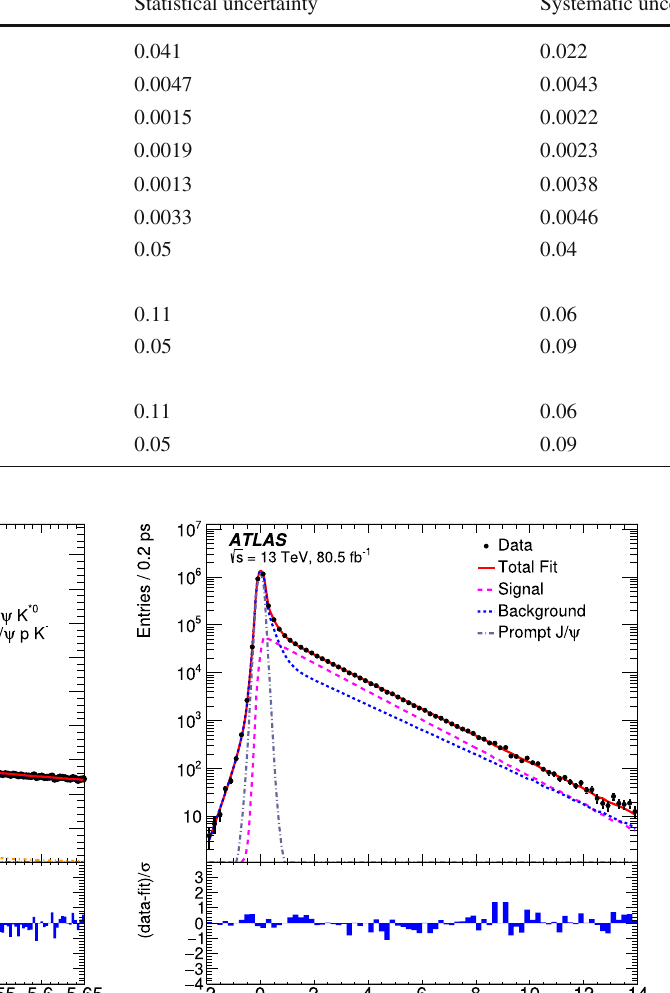
Table 6 Fitted values for the physical parameters of interest with their statistical and systematic uncertainties. For variables δ ⊥ and δ (cid:10) the values are given for the two solutions (a) and (b). The difference in